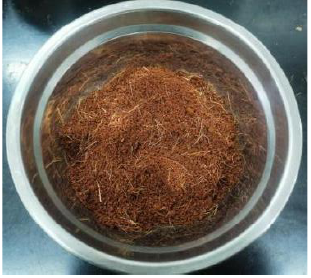
Figure 2. Coir fiber incorporated in soil.